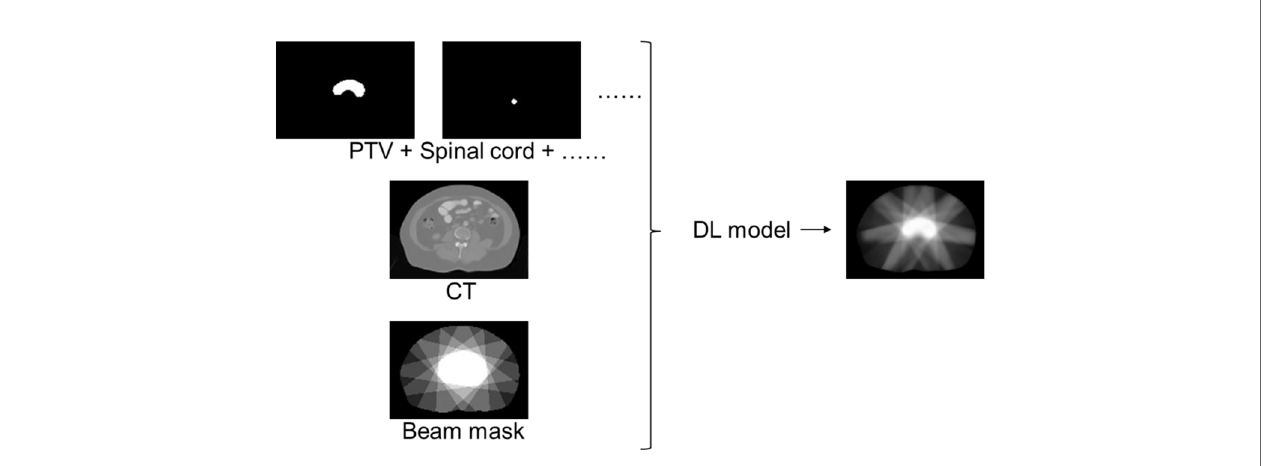
FIGURE 2 | Data preparation